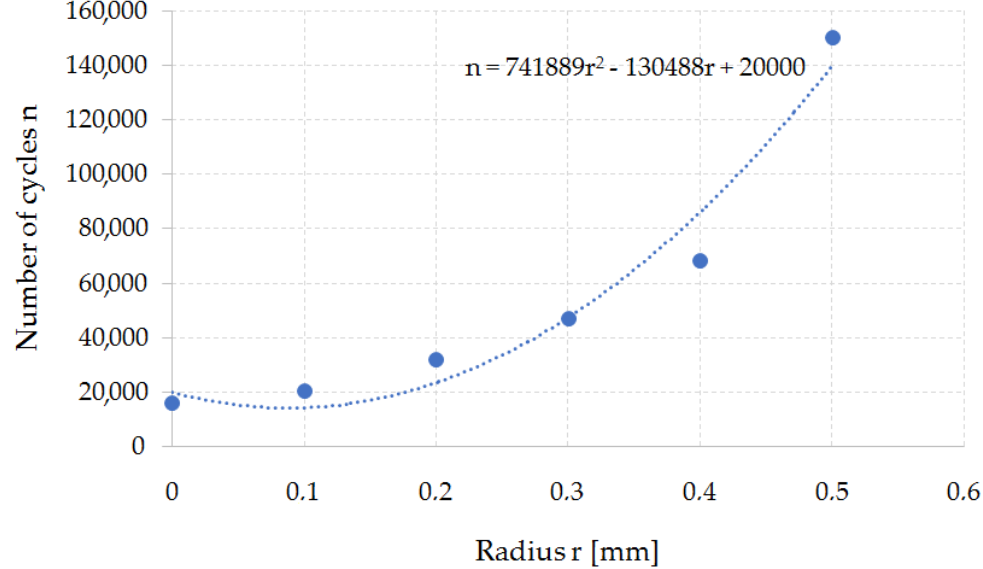
Figure 15. Graph of the dependence of the fatigue wear resistance as a function of the punch cutting edge rounding radius n = f (r).